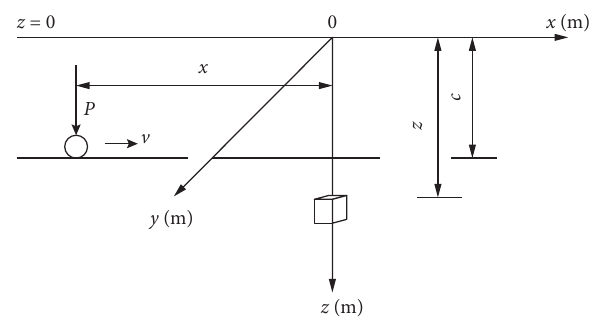
Figure 2: Stress state of the soil element under a single wheel